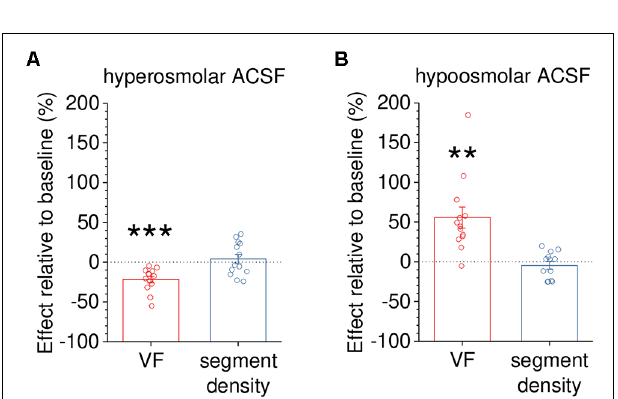
FIGURE 5 | Continued Tukey post hoc p < 0.05 for week 2 vs. 27 and week 2 vs. 80). Right: segment density (one ANOVA p < 0.0001; Tukey post hoc p < 0.0001 for all combinations of weeks 2 and 3 vs. weeks 3–80). Individual circles represent measurements from single astrocytes. Box represents mean and 25th and 75th percentile. Whiskers represent 5th and 95th percentiles. (C) The volume fraction and segment density were measured in cross-sections of astrocytes from the stratum oriens (SO, n = 27), stratum radiatum (SR, n = 55) and stratum lacunosum-moleculare (SLM, n = 50). A total of six mice 6–8-week-old were used. Both parameters were analyzed in regions of interest sparing the somatic region (see Figure 2A ). Somatic reference region as elsewhere. Left panel: volume fraction comparison (Kruskal Wallis p = 0.0110, Dunn post hoc p < 0.05 for SR vs. SO and SLM). Right panel: segment density comparison (Kruskal Wallis p < 0.0001; Dunn post hoc